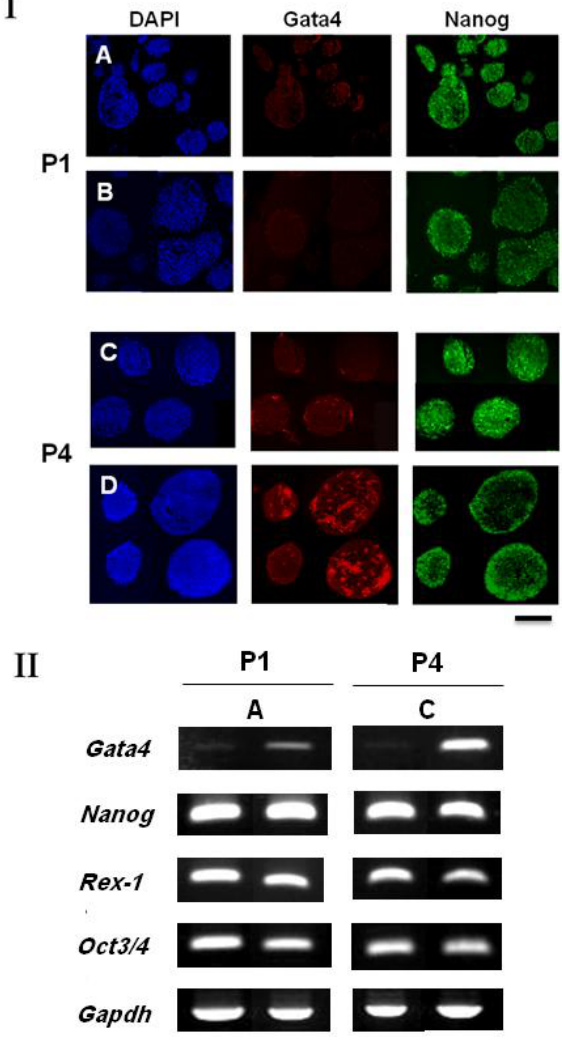
Figure 3. Characterization of spherical colony of ES cells grown on GLU/D surface and bacteriological dish at passages 1 and 4. ( I ) Fluorescent images of immunostaining with DAPI (blue), anti-Gata4 (red) and anti-Nanog (green). Panels A and C show the spherical colony cells on the GLU/D surface at passages 1 and 4, respectively. Panels B and D show the cell aggregates on the bacteriological dish at passages 1 and 4, respectively. The scale bar represents 100 µm. ( II ) RT-PCR analyses for Gata4, Nanog, Rex-1 and Oct 3/4. Lanes A and C show the spherical colony cells on the GLU/D surface at passages 1 and 4, respectively. Lanes B and D show the cell aggregates on the bacteriological dish at passages 1 and 4,